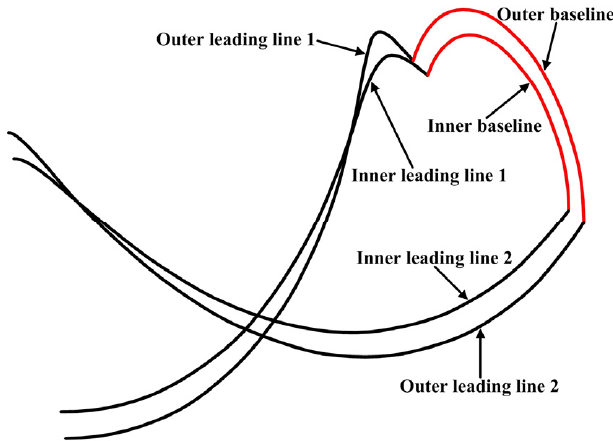
Figure 2. Generated spiral entities.